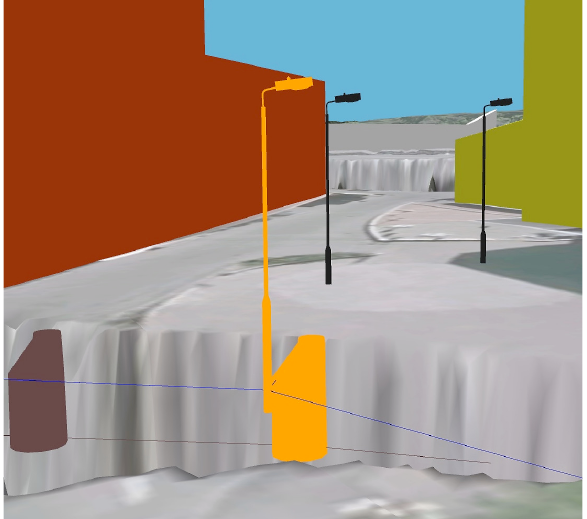
Figure 5. Light pole moves too close to manhole – the colour changes to